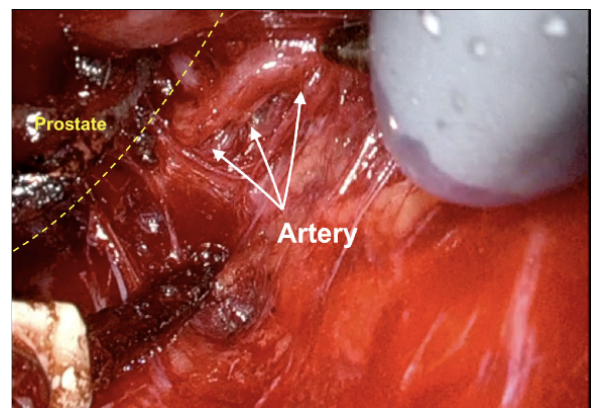
Figure 1 - Posterior medial prostatic artery on the right side.